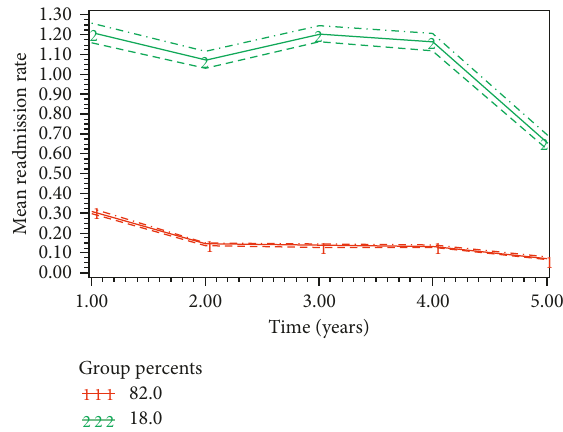
Figure 1: Subgroups among elective AAA repair patients and their trajectories of unplanned readmission rates (the horizontal axis starts with annual readmission rate at year one, and the dotted lines represent 95% confidence intervals for each